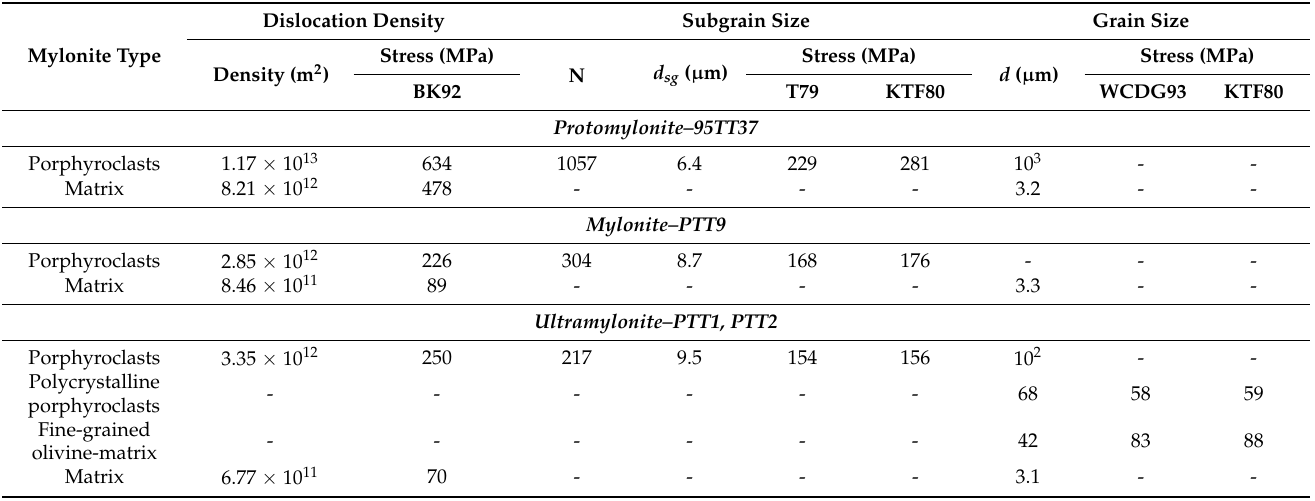
Table 1. Paleostress